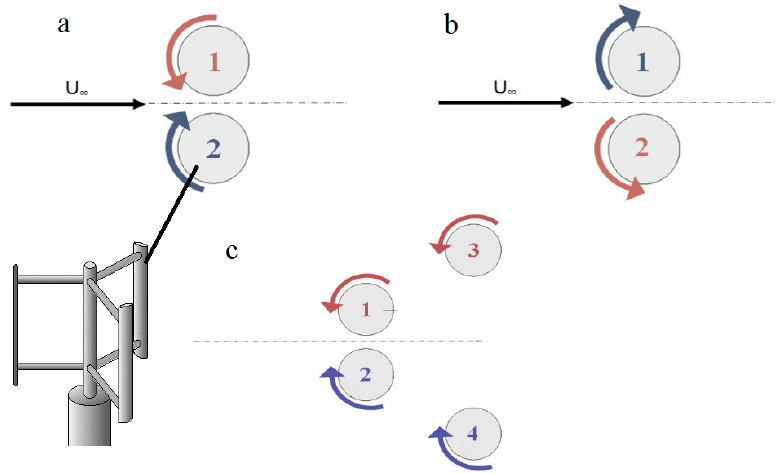
Figure 10. Schematic diagram of close proximity VAWT in ( a ) inward counter-rotating; ( b ) outward counter-rotating; ( c ) 4-rotors configuration.